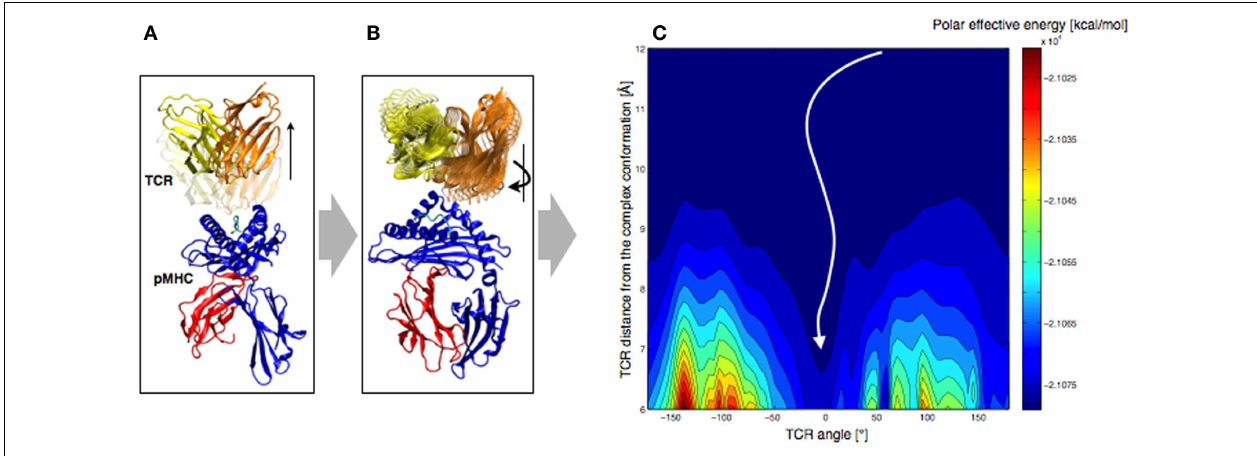
FIGURE 7 | Rigid displacement protocol . (A) RigidTCR translation along the principal axis. (B) RigidTCR rotation around the principal axis. (C) Landscape representation of theTCR-pMHC polar energy as a function of theTCR/pMHC distance and theTCR angle. 0° corresponds to the native orientation of the bound